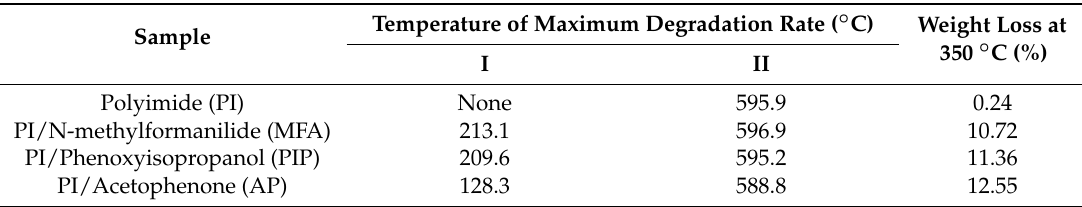
Table 1. Temperatures of maximum degradation rate of the PI fibers treated with swelling agents and the weight loss at 350 °C.